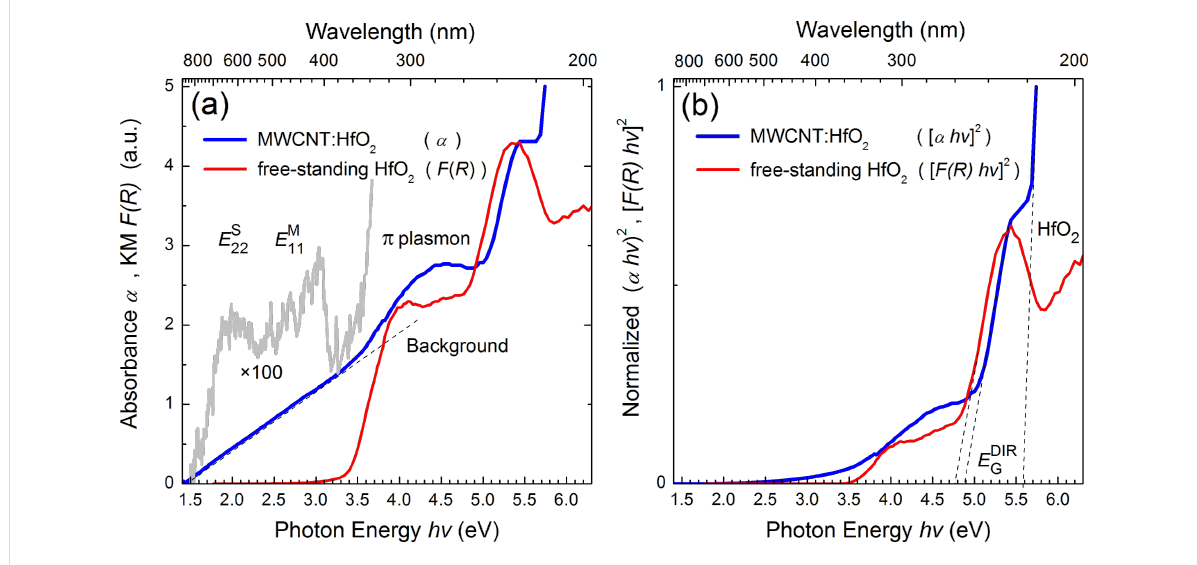
Figure 2: (a) Absorption spectrum of MWCNTs decorated with cubic HfO 2 nanoparticles obtained from the transmittance measurements of colloidal suspension in ethanol (blue curve) against that of free-standing HfO 2 nanoparticles from the diffuse reflectance measurements (red curve). (b) Tauc plots of the corresponding dependencies, absorbance ( α ) and Kubelka–Munk function (KM F ( R )), representing the case of direct optical transitions.